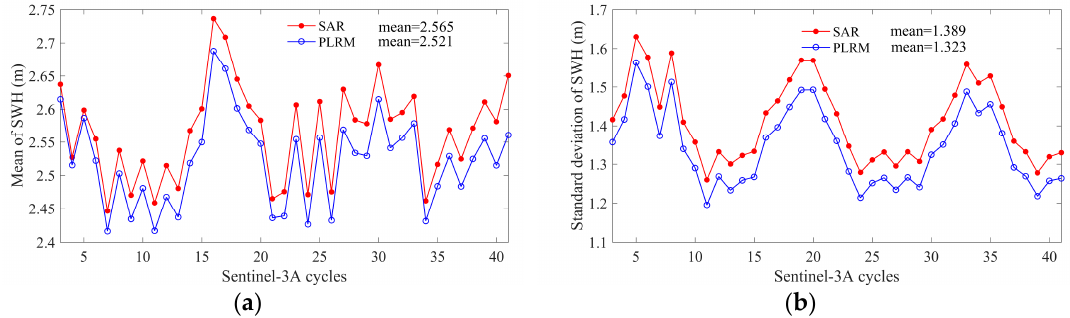
Figure 10. Cycle by cycle ( a ) means and ( b ) standard deviations of SWHs according to Sentinel-3A repeat cycles.